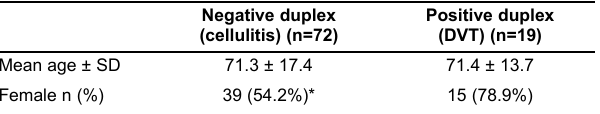
TABLE 1 Demographic data